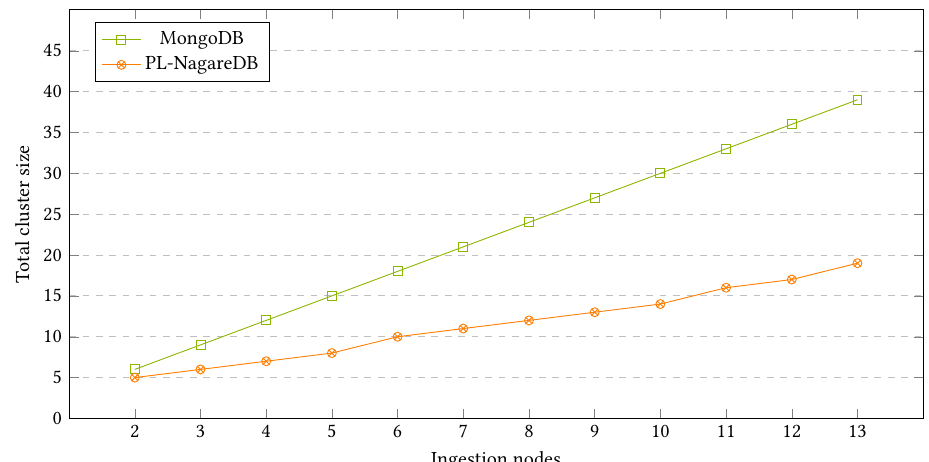
Figure 11. Total cluster size per ingestion node comparison between MongoDB and NagareDB, Figure 1: Total cluster size growth, according to the amount of nodes involved in direct data ingestion. representing our approach for scalability. MongoDB’s cluster grows 3 by 3, as each node is multi- Table 1: Queries execution time, and standard deviation, in seconds. COL SIZE 2 purpose and typically replicated three times. PL-NagareDB’s cluster grows one by one, since it is possible to grow only in the Ingestion Replica Set, as nodes are specialized. Once each secondary Operation ID Simultaneous jobs Row size node that grows vertically reaches its limit (5 shards, in this case), an extra new machine is NCOL:1x500